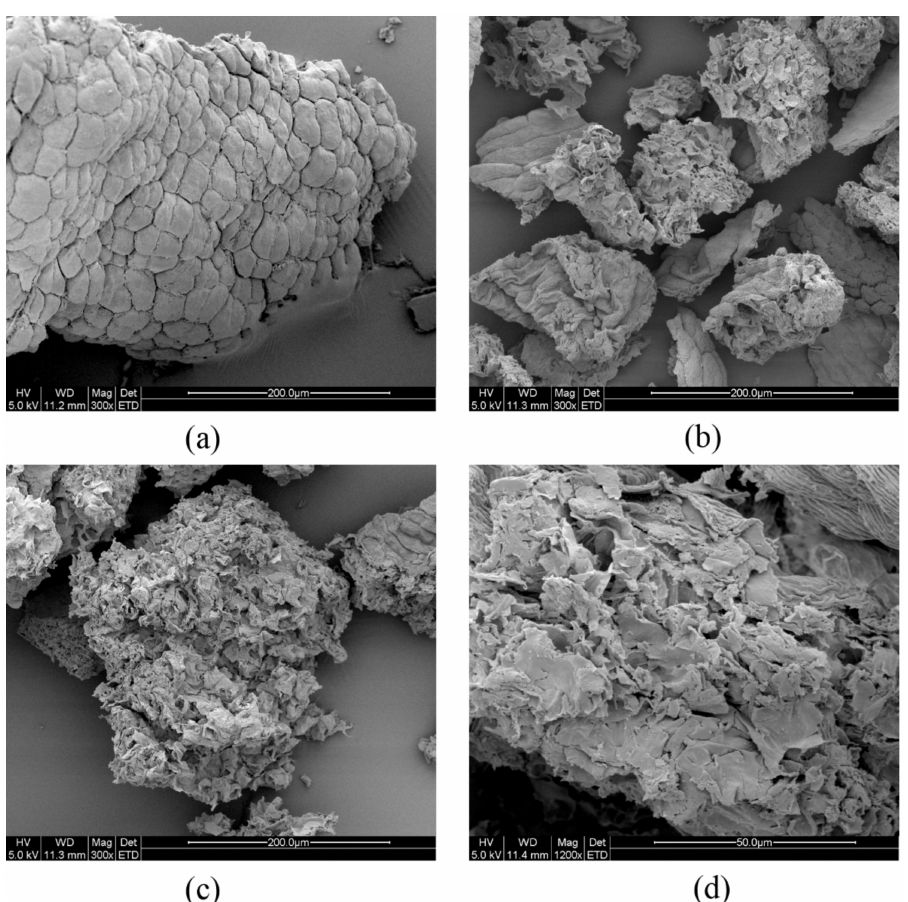
Figure 1. Scanning electron micrographs of cell surfaces: ( a ) Cells before treatment; ( b ) cells with MAE; ( c ) cells with UAE; ( d ) cells with SC-MUAE